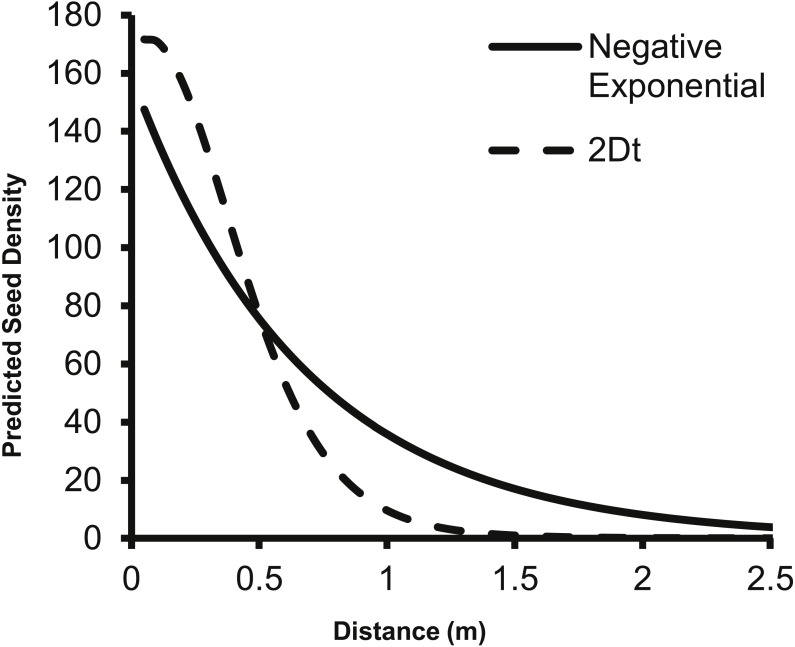
The change in predicted seed density as distance from the parent plant increases as predicted by the negative exponential function from Eschtruth & Battles (2009) and the 2Dt g(r) function.The fecundity of the parent plant was set to 156 seeds as this was the value used by Eschtruth & Battles (2009). Beginning at 0.50 meters, the negative exponential overestimates the dispersed seed density compared to the 2Dt g(r) kernel.